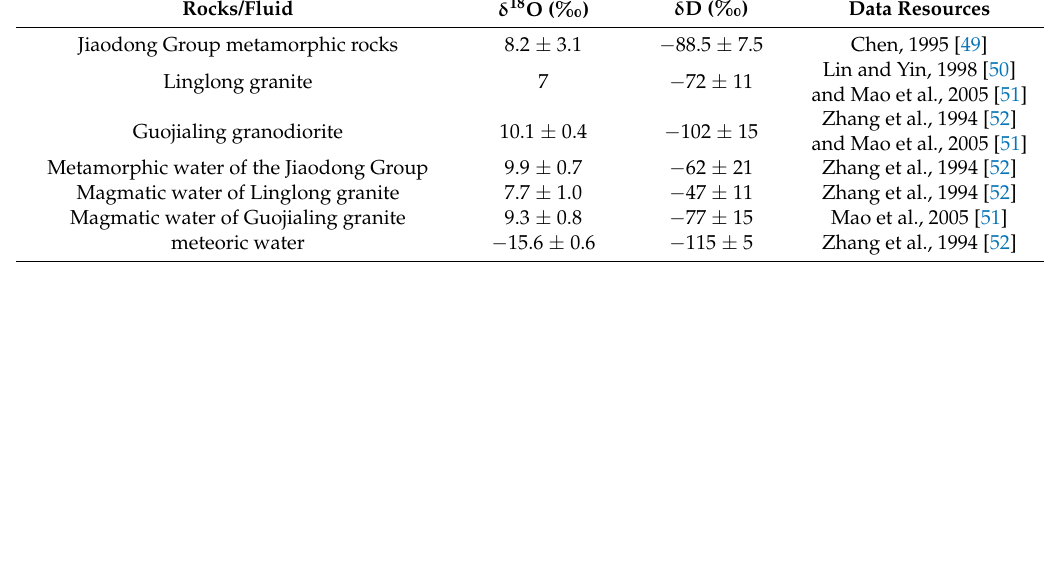
Table 4. The H–O isotope geochemical background in the Jiaojia gold belt. Rocks/Fluid δ 18 O ( ‰ ) Jiaodong Group metamorphic